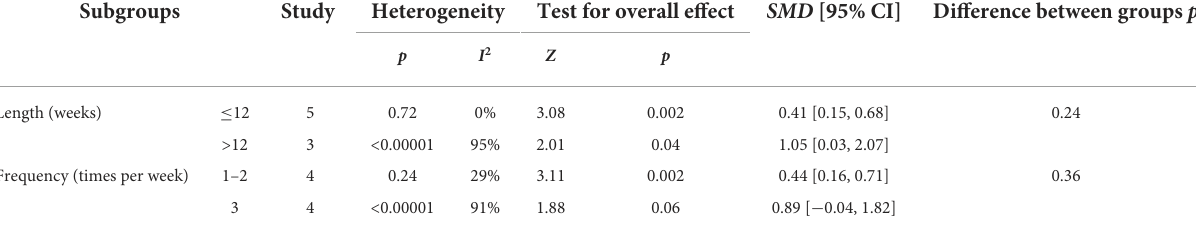
TABLE 5 Effects of different intervention lengths and frequencies on global cognition